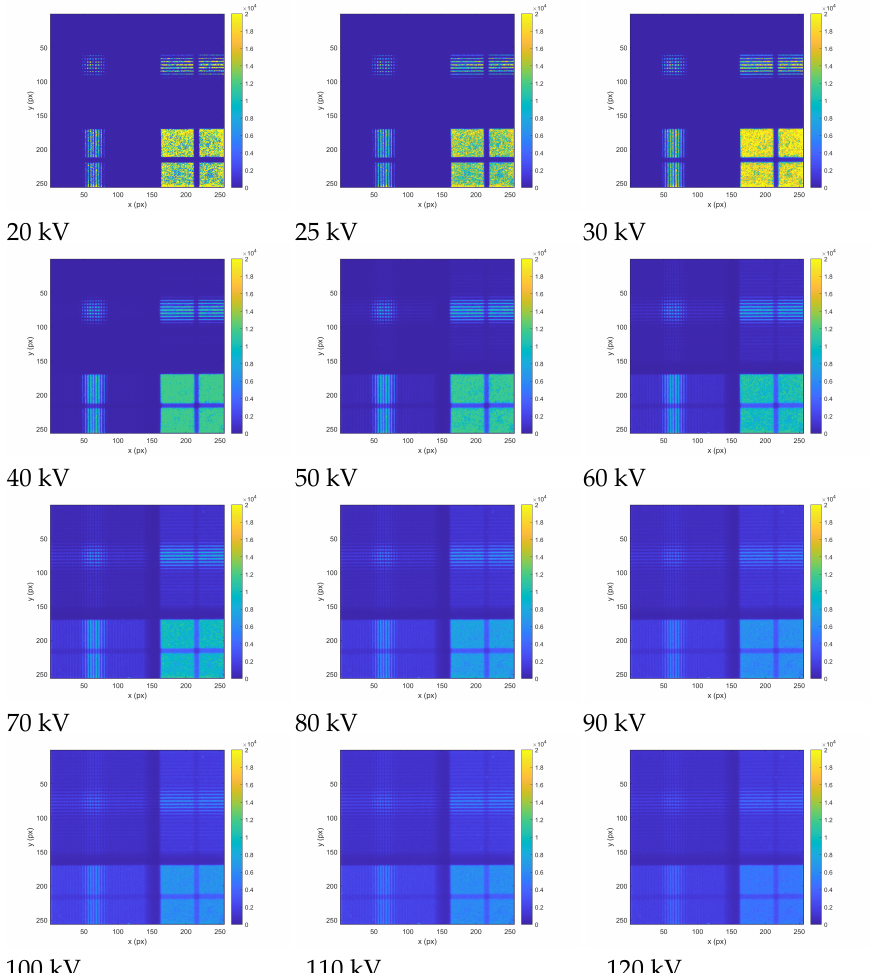
Figure 7. Laboratory test of detection and imaging response of collimated X-rays by the developed payload. X-ray images were acquired in counting mode by the Timepix detector with a 2000 µ m CdTe sensor and correspond to the entire pixel detector matrix (14 mm × 14 mm). The X-ray source consisted of an X-ray RTG unit with wolfram anode operated in the range 20 kV to 120 kV. The X-ray images reveal the response to the specific optical-collimating regions. The per-pixel intensity (event count rate) is displayed in color.